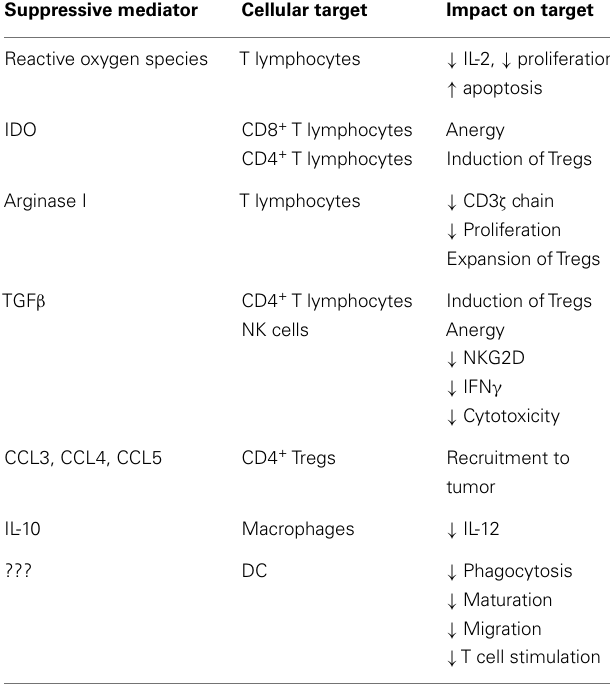
Table 2 | Mechanisms of immune suppression by